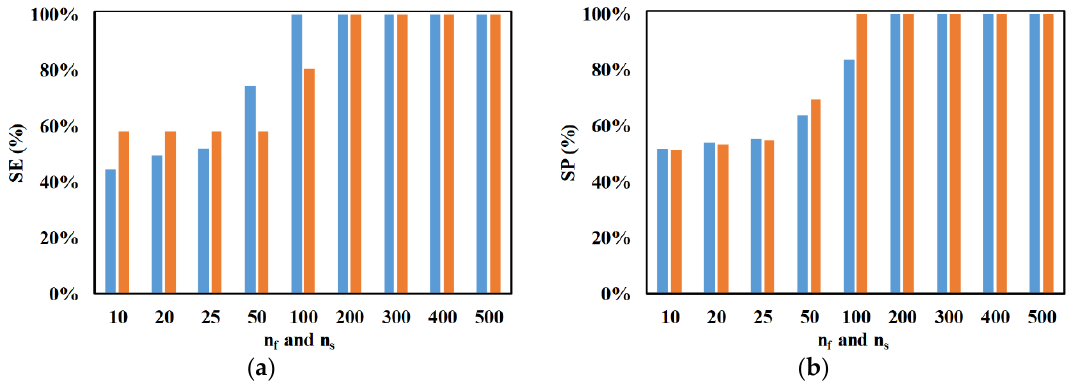
Figure 8. Variation of SE and SP with number of electrode pairs (n f and n s ) for ( a ) ■ 2 μm and ( b ) ■ 2.25 μm ( d f = 60 μm, l f = 120 μm, d s = 60 μm, l s = 120 μm, w f = 6 μm, w s = 6 μm, Q m = 200 μL/h, V 1 = 3 V pp , V 2 = 15 V pp , V 3 = 15 V pp V 4 = 3 V pp , H ch = 50 μm, W ch = 50 μm, 0 < W o,2.25 < 30 μm, 30 μm < W o,2 < 50 μm, N 1 = N 2 = 10 MHz, N 3 = N 4 = N cr,2 = 473 kHz).